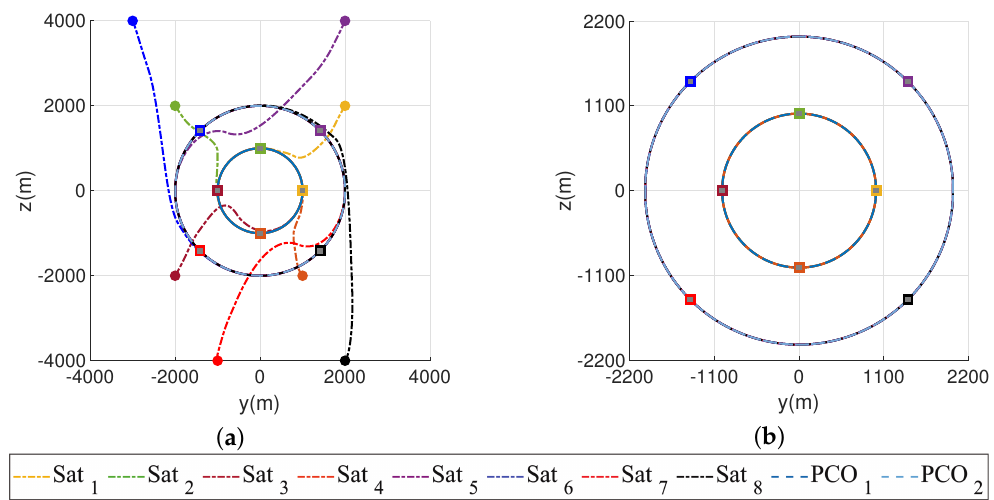
Figure 14. PBC law. Plots of trajectories: ( a ) on plane YZ; ( b ) on plane YZ after orbiting.